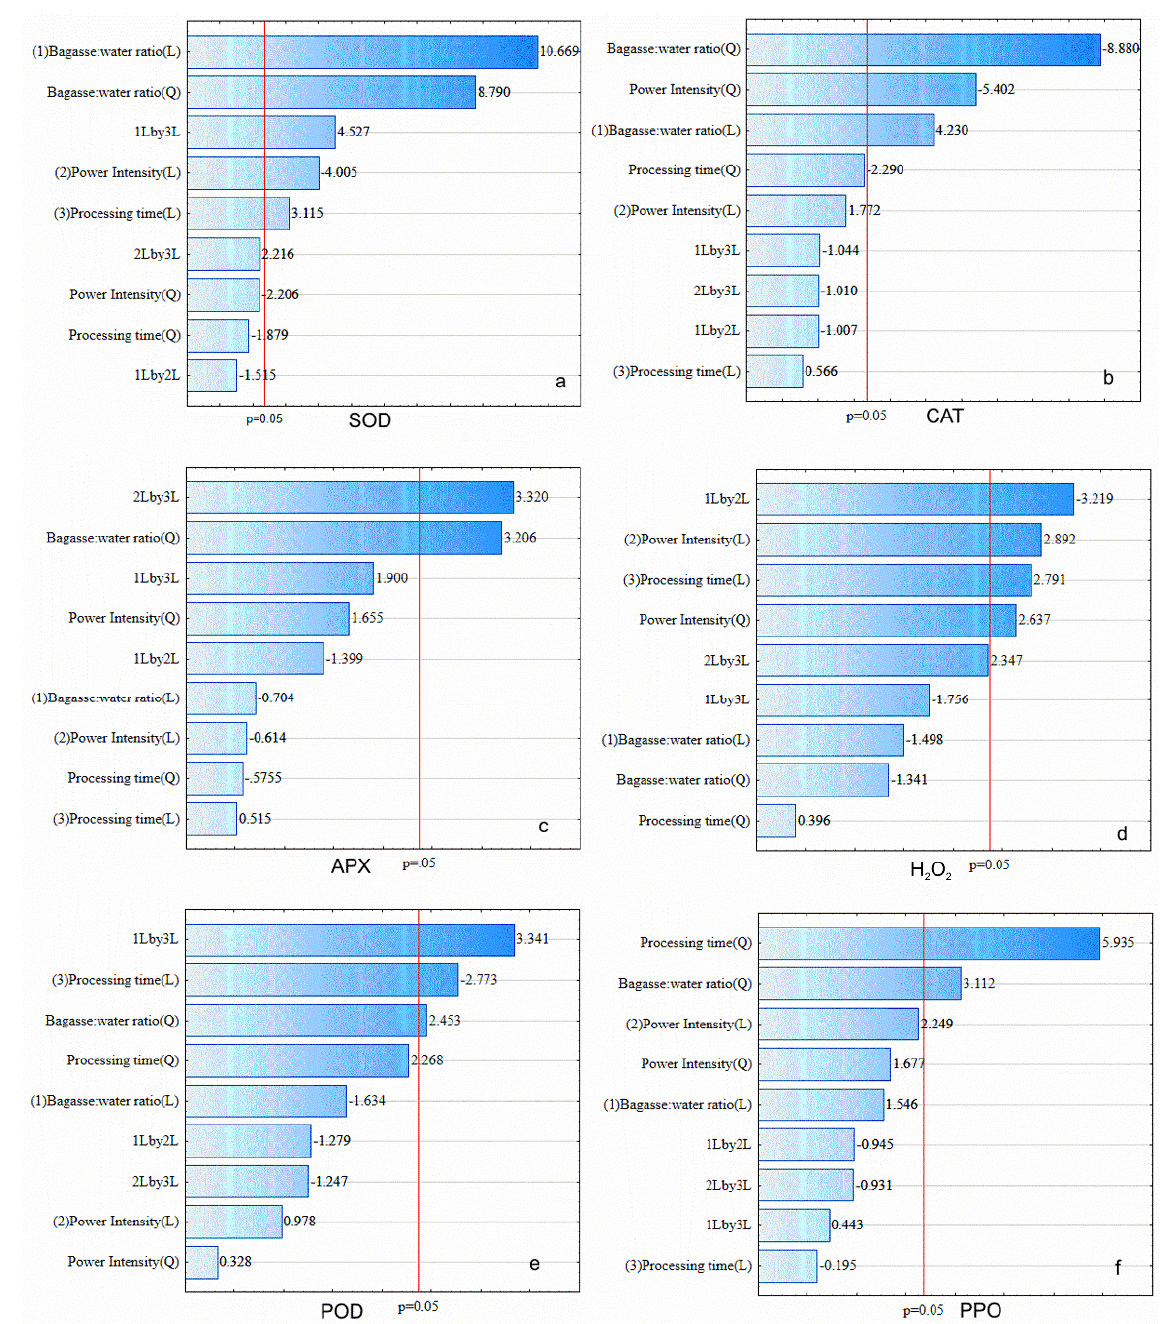
Figure 1. Pareto charts for the effect of sonication on S.O.D. (superoxide dismutase) ( a ), C.A.T. (cata- lase) ( b ), A.P.X. (ascorbate peroxidase) ( c ), H 2 O 2 (hydrogen peroxide content) ( d ), P.O.D. (peroxidase) ( e ), P.P.O. (polyphenol oxidase), and ( f ) activities of cashew apple bagasse. Table 2. Experimental design and S.O.D. (superoxide dismutase), C.A.T. (catalase), A.P.X. (ascor- bate peroxidase), P.P.O. (polyphenol oxidase), and P.O.D. (peroxidase) activities and H 2 O 2 content after sonication of cashew apple bagasse puree.